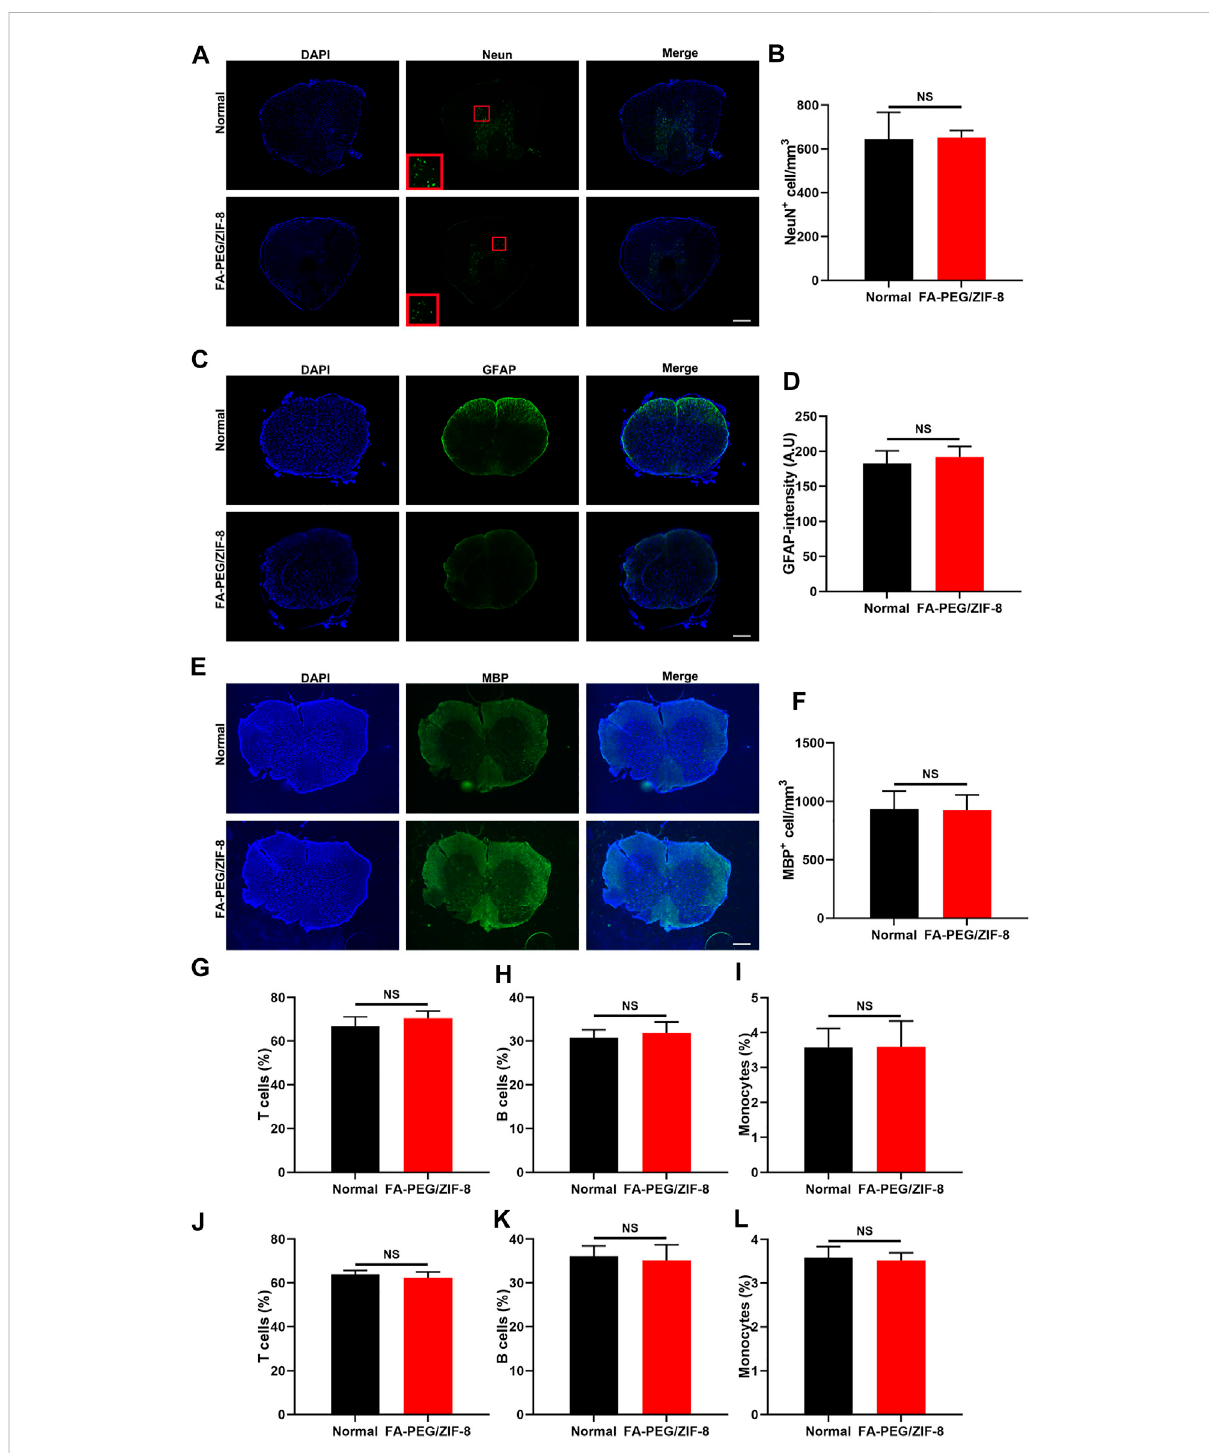
FIGURE 4 The targeting effect of FA-PEG/ZIF-8 in vivo . Representative expression and quanti fi cation analysis of Neun (A,B) , GFAP (C,D) , and MBP (E,F) in FA-PEG/ZIF-8andWT groups.Scalebars=200 µm.Quanti fi cationanalysis ofTcells (G,J) ,Bcells (H,K) ,andmonocytes (I,L) inthebloodandspleen of FA-PEG/ZIF-8 and WT groups. Data are presented as the mean±SD. Two-tailed Student ’ s